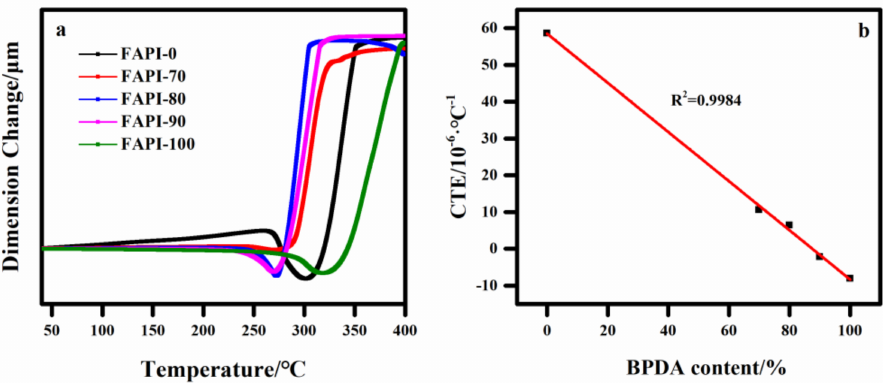
Figure 9. ( a ) TMA curve of the FAPI films; ( b ) The relationship between CTE and biphenyl content in polymer